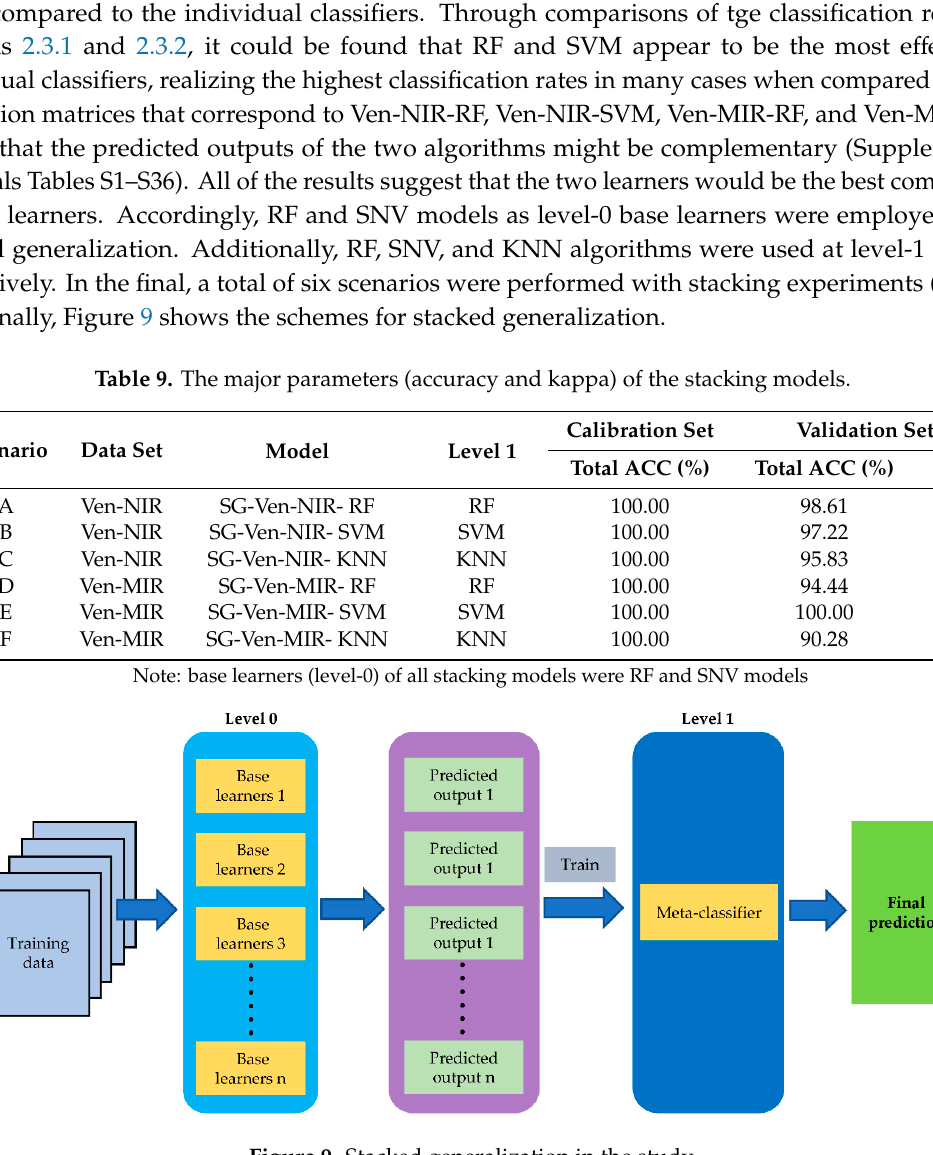
Figure 9. Stacked generalization in the study.